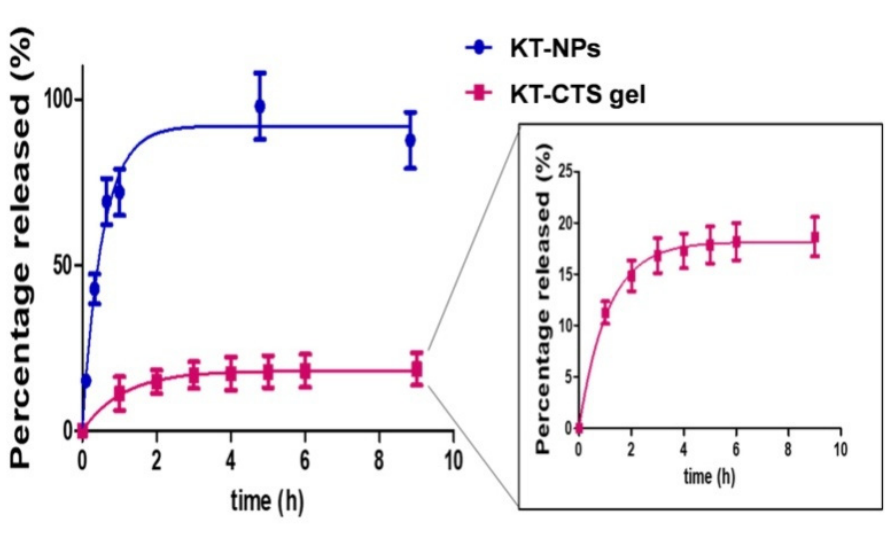
Figure 5. In vitro release profile of the formulations, KT-NPs and KT-CTS gel ( p < 0.001). Each value represents mean ± SD ( n = 6).